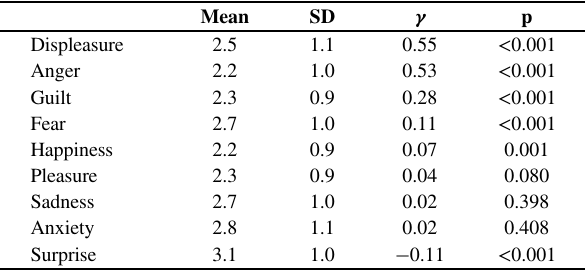
Table 4 Correlation between the resistance score and emotional responses